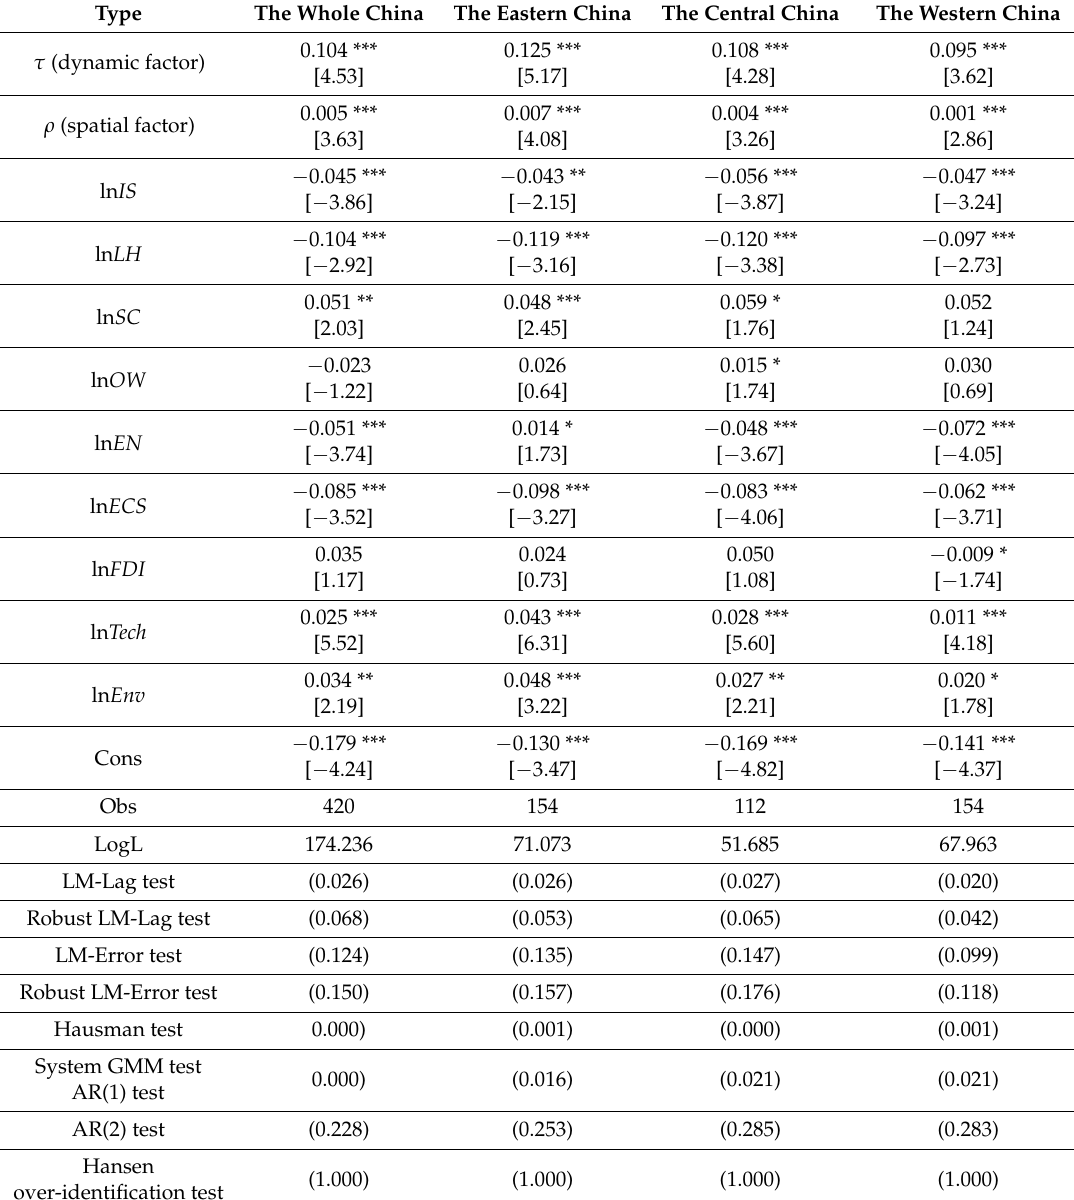
Table 7. Estimation results of robustness